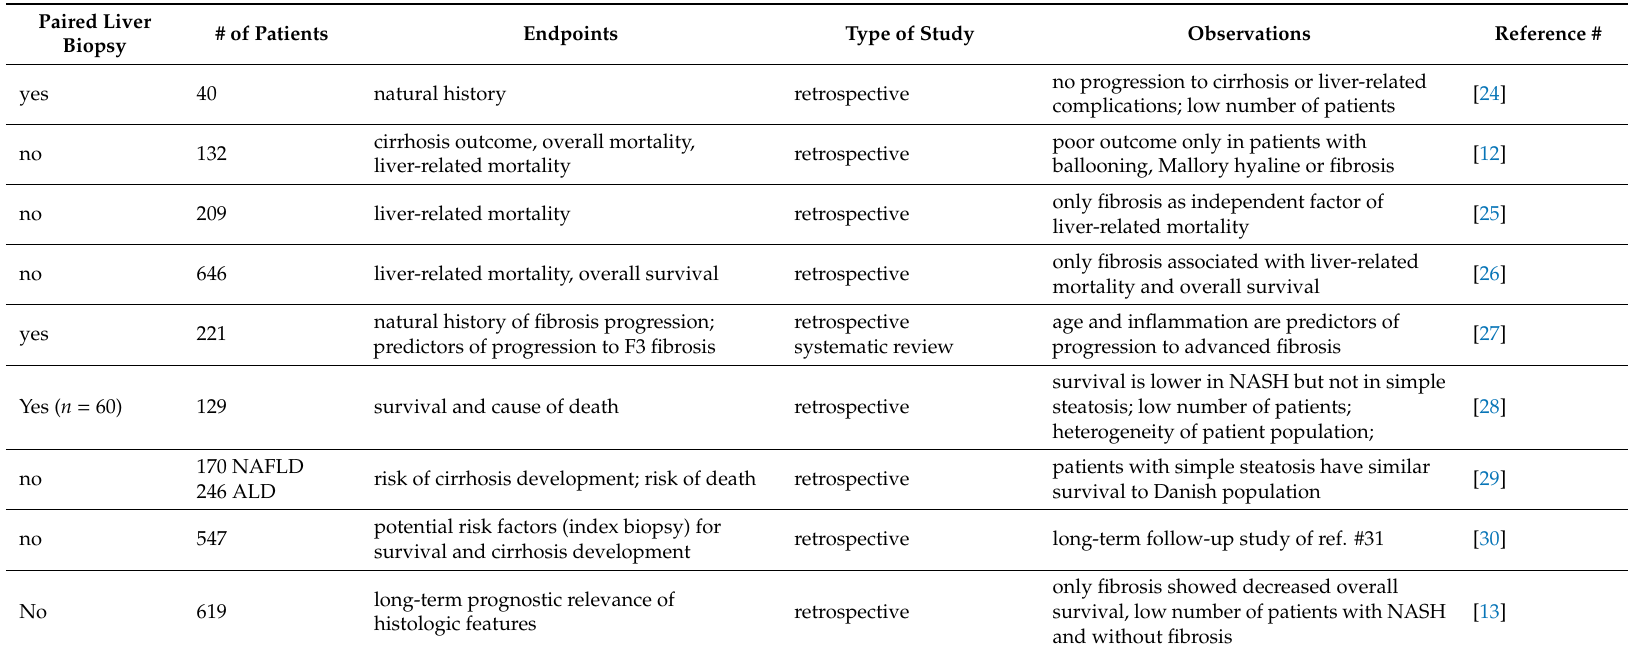
Table 1. Evidence in favor of the good prognosis of NAFL